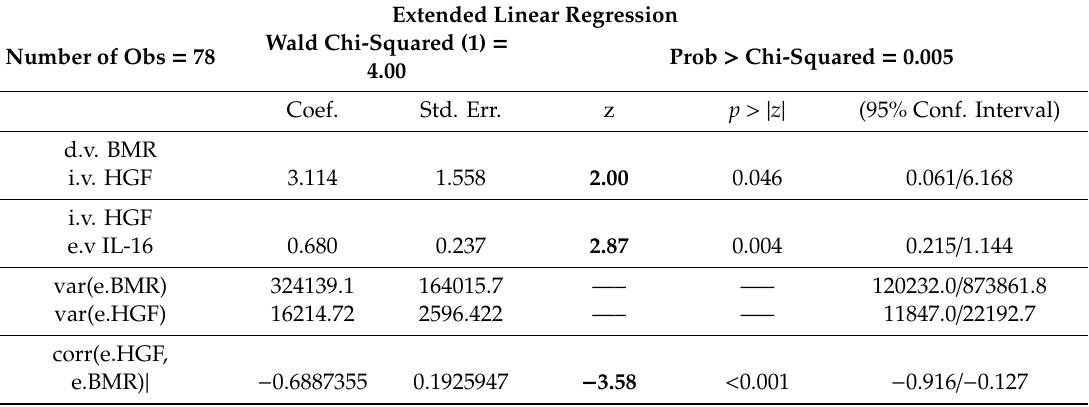
Legend to Table 6: BMR, basal metabolic rate, HGF, hepatic growth factor; IL-16, interleukin-16. The correlation estimates tells us about the endogeneity in our model of extended linear regression, i.e., IL-16 is an endogenous variable, playing likely a causal role. Although the Prob > chi2 was significant due to the large coe ffi cient, the F-statistic (Wald chi square) against the null, i.e., the excluded endogenous variable are irrelevant in the first-stage regression, should have been larger than 10 to demonstrate that instruments / covariate / endogenous / explanatory variables are weak according to Staiger and Stock’s Rule of thumb; d.v., dependent variable; e.v., endogenous variable; i.v., independent variable. In bold are highlighted the significant ones and the correlation